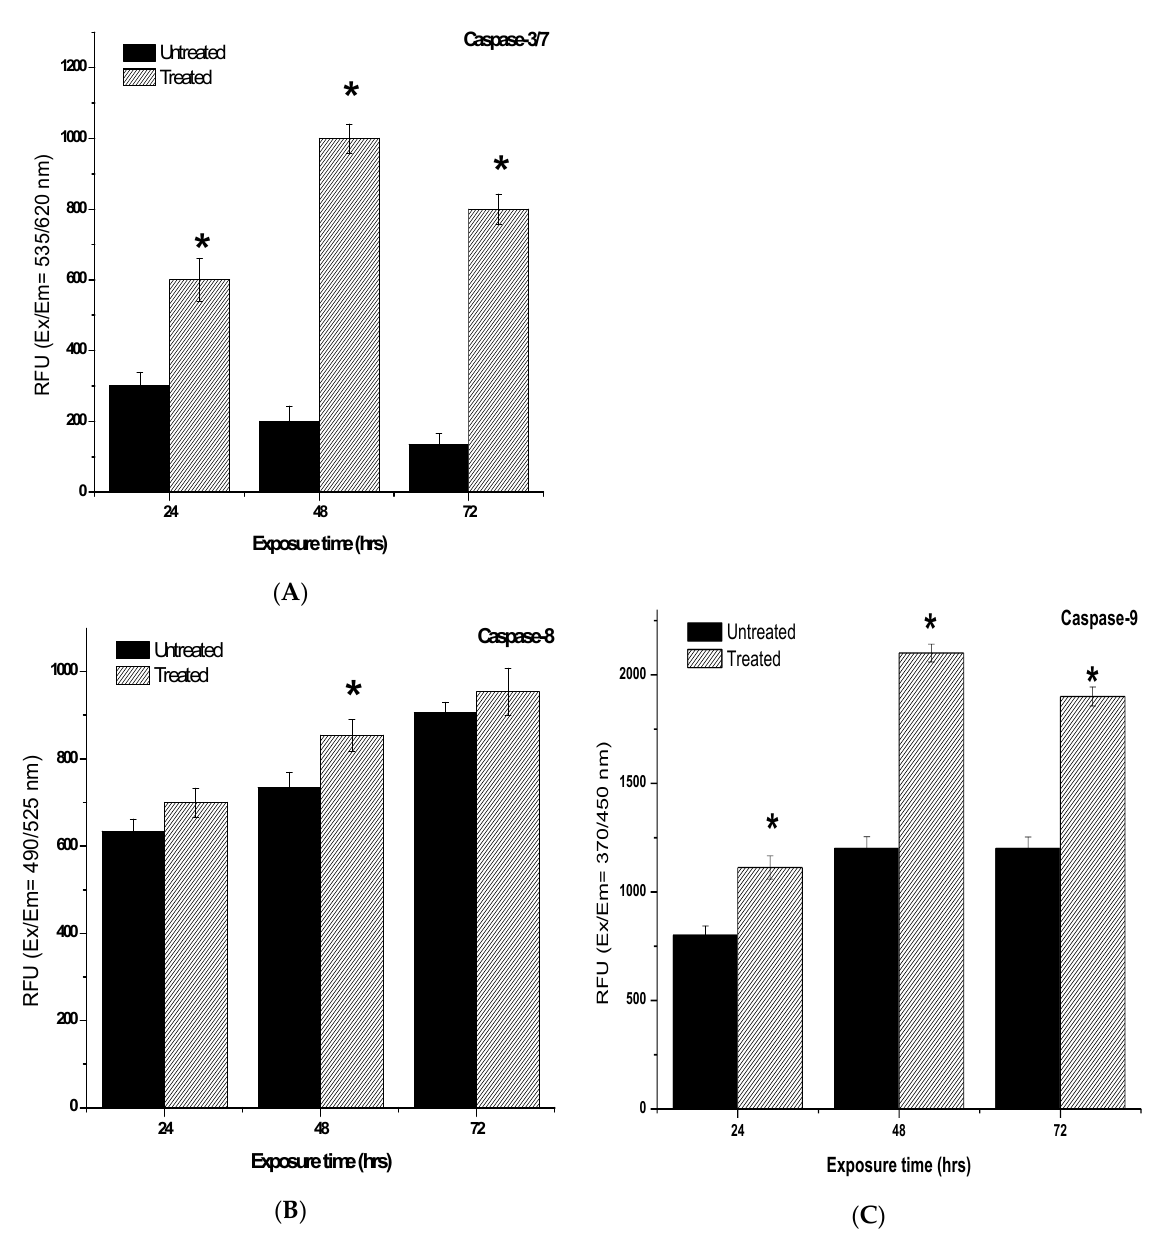
Figure 25. The caspase-3/7, -8 and -9 activities in MDA-MB-231 cells treated for 24, 48 and 72 h. Each data point represents the mean of three independent experiments ± SD. * Significantly different from the control ( p < 0.05). ( A ) 24 h, ( B ) 48 h and ( C ) 72 h of incubation.